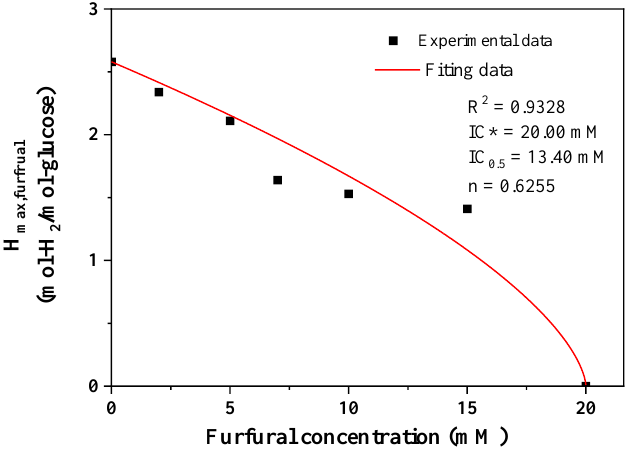
Figure 2. Hydrogen production potential in response to different concentrations of furfural derived from the extended Monod model.